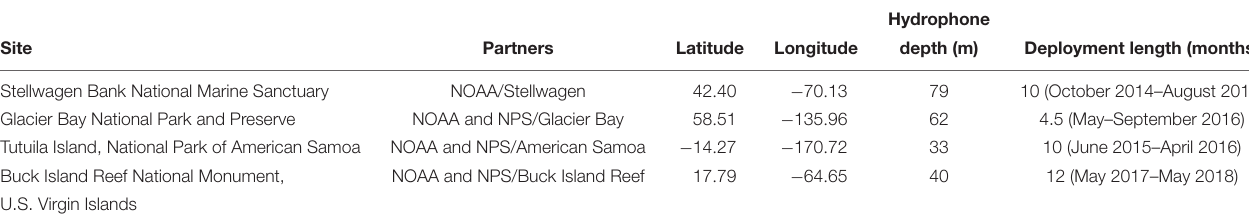
TABLE 1 | Hydrophone deployment site